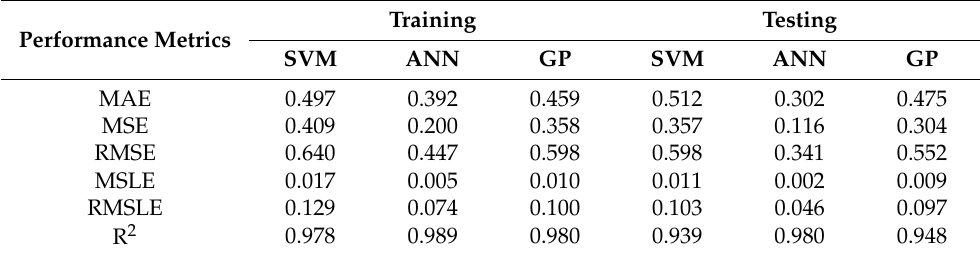
Table 9. Results of all three AI models in predicting CBR for both training and testing databases. Performance Metrics